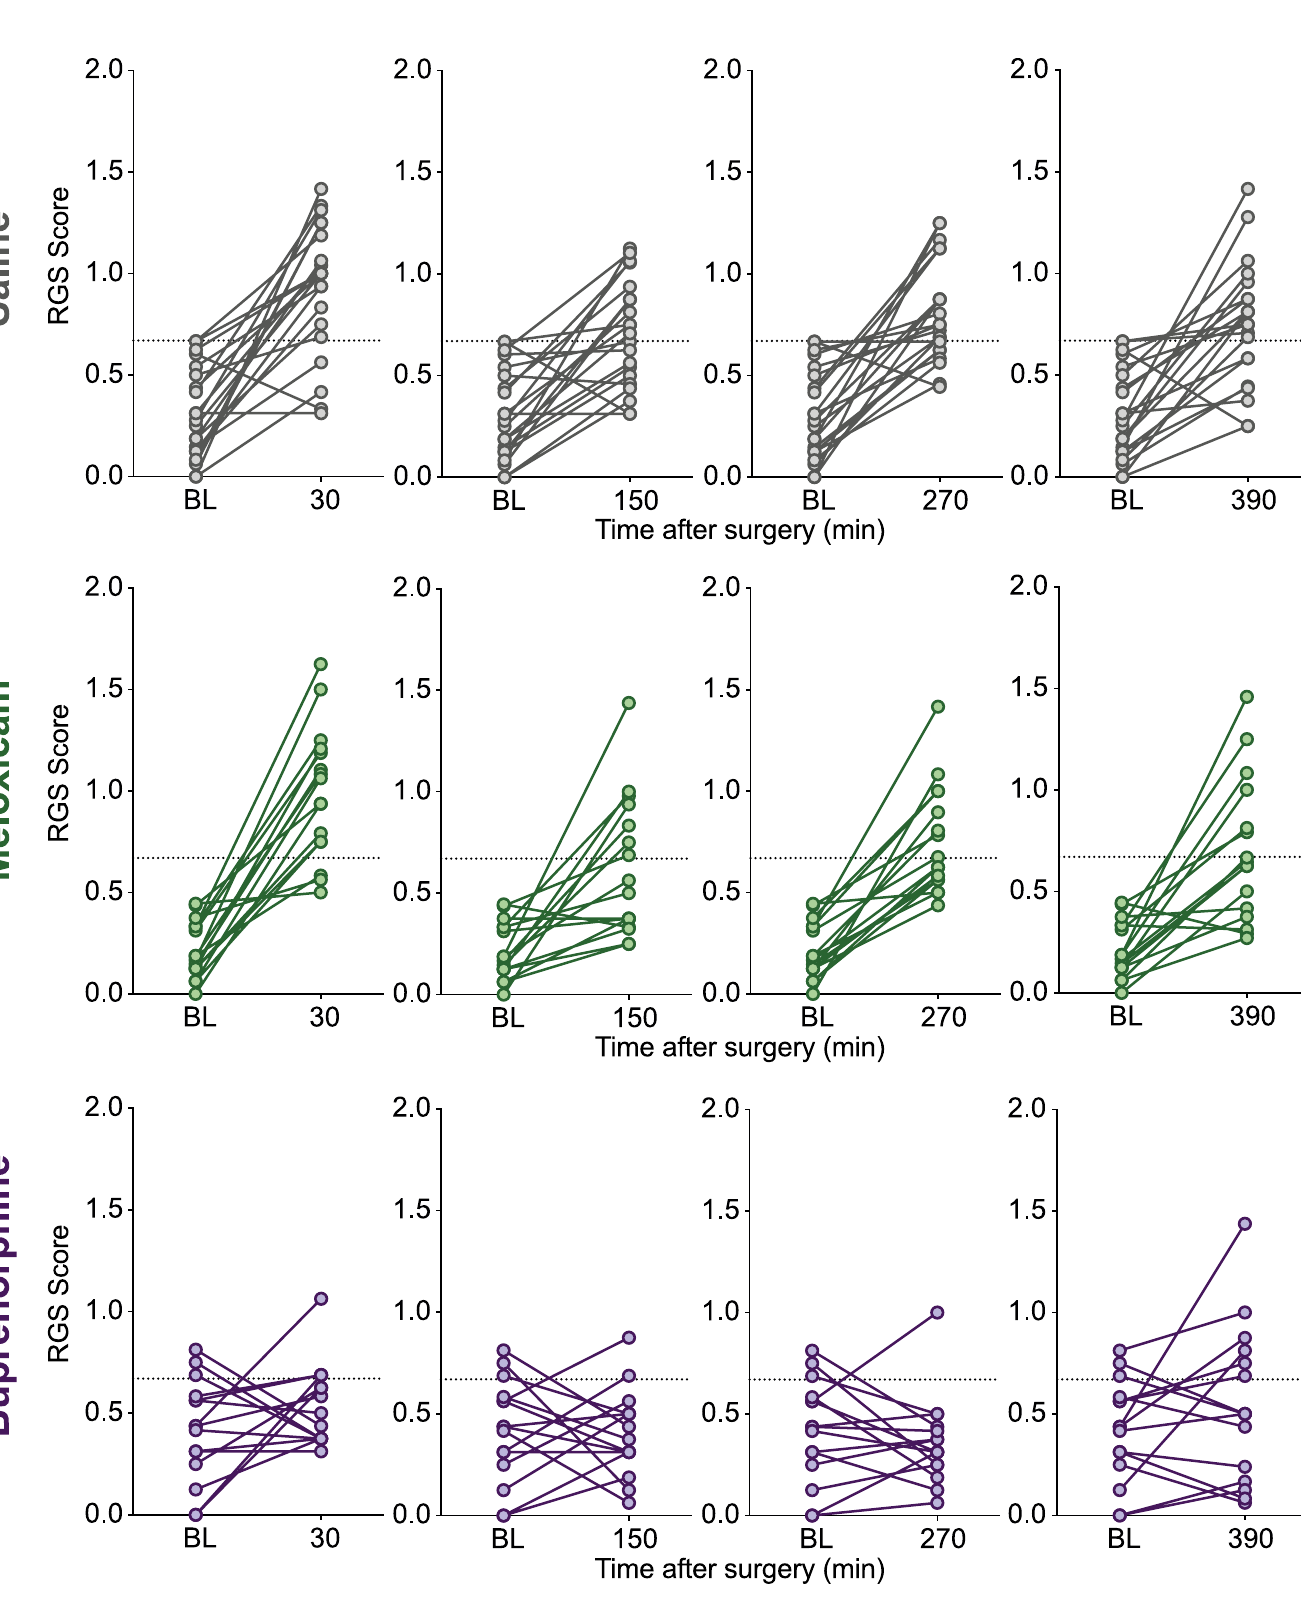
PLOS ONE | https://doi.org/10.1371/journal.pone.0209467 May 31,